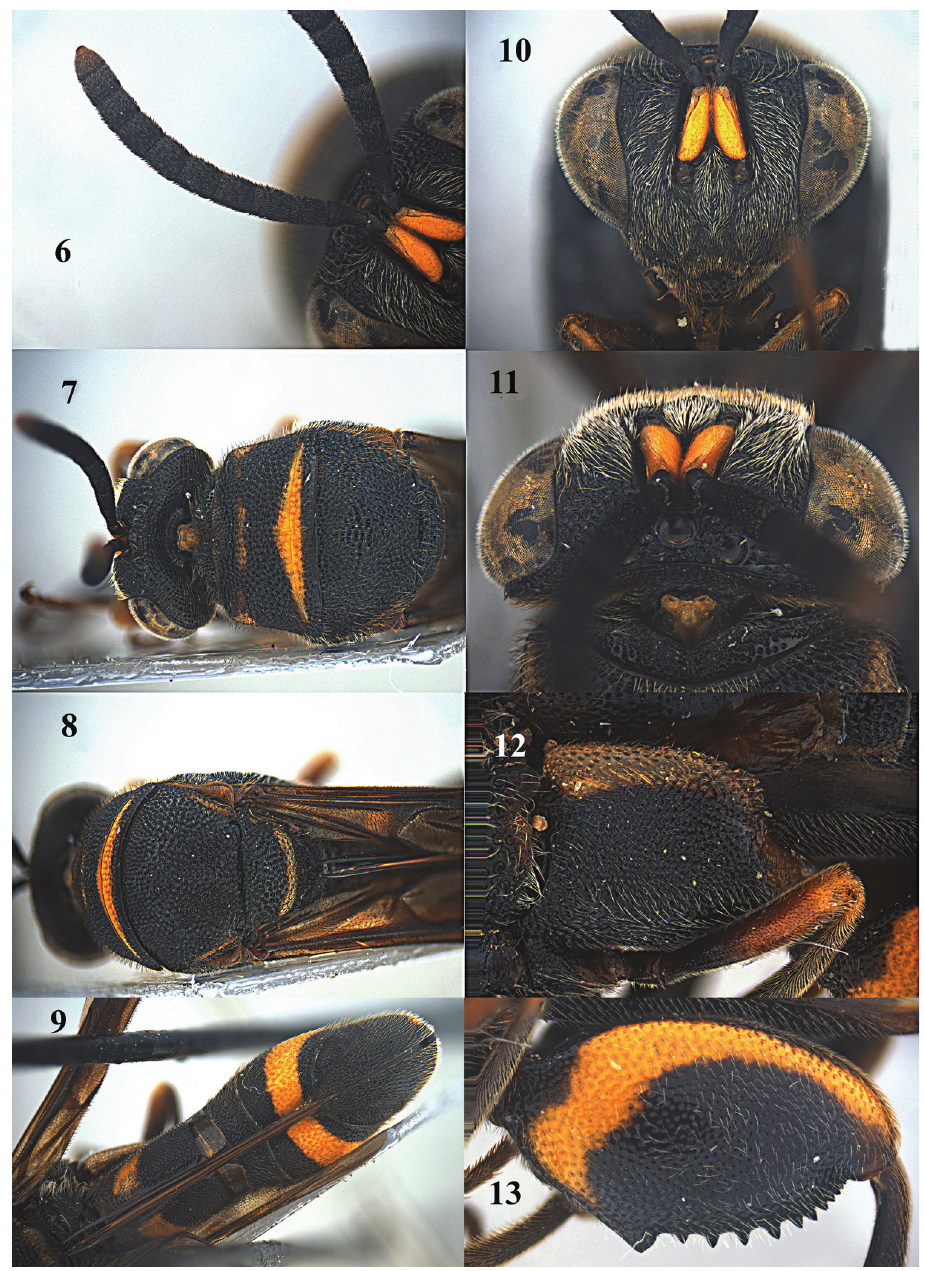
Figures 6–13. Leucospis japonica Walker, ♀ from Guangxi. 6 Antenna 7 pronotum and mesoscutum dorsal 8 mesosoma dorsal 9 metasoma dorsal 10 head frontal 11 head dorsal 12 hind coxa. 13 hind